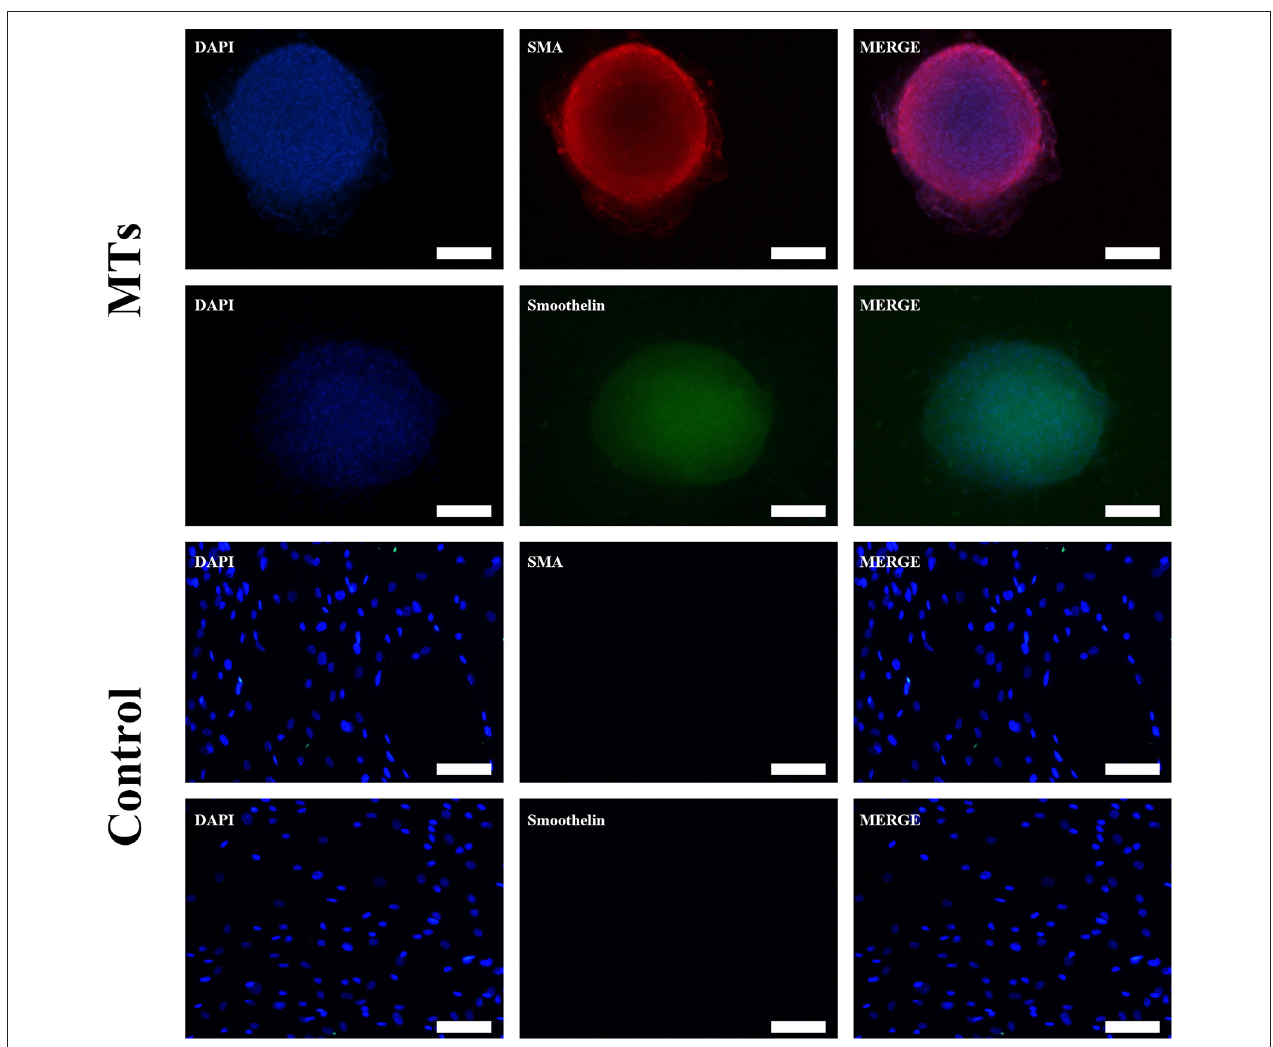
FIGURE 4 | Smooth muscle differentiation of MTs and the control group. The immunofluorescence detected α -SMA and smoothelin expression in microtissues (MTs) and hADSCs cultured in a Petri dish (Control). Inset bar = 100 µ m.